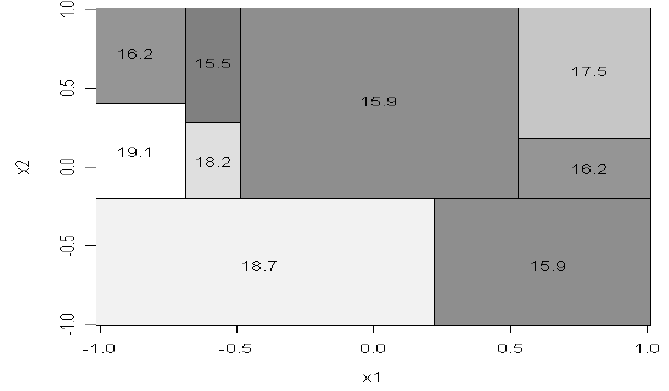
Figure 9 – Partition of D and values of Y for the model used in the simulation experiment 2.